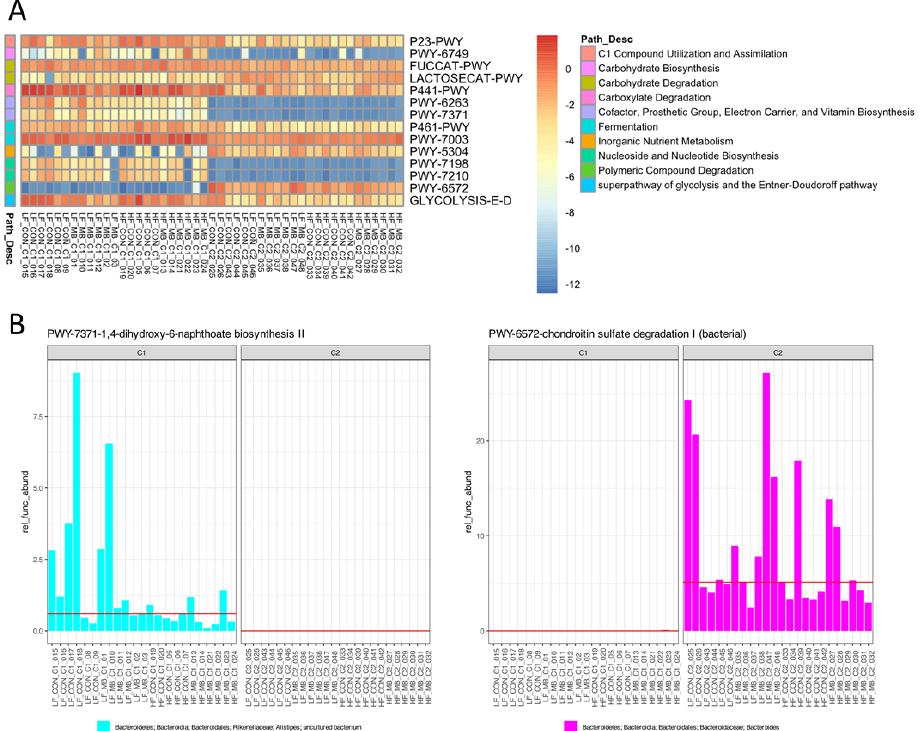
Figure 7. Metacyc pathways identified as di ff erentially abundant between cohorts by metagenome inference using PICRUSt2. ( A ). Heatmap of most highly upregulated and downregulated Metacyc pathways across cohorts selected by Benjamini–Hochberg-adjusted Welch’s t test and Wilcoxon rank sum p ≤ 0.05 and e ff ect cuto ff of ± 1. ( B ). Two pathways that demonstrated unique abundance in cohort 1 ( left ) or cohort 2 ( right ) shown with their contributing